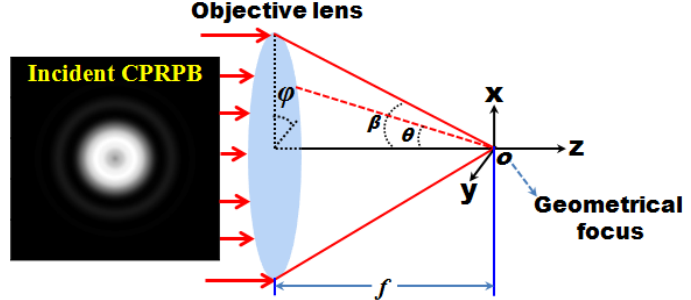
Figure 1. Intensity distribution of incident linearly polarized CPRPB (left) and schematic of a tight-focusing setup (right).